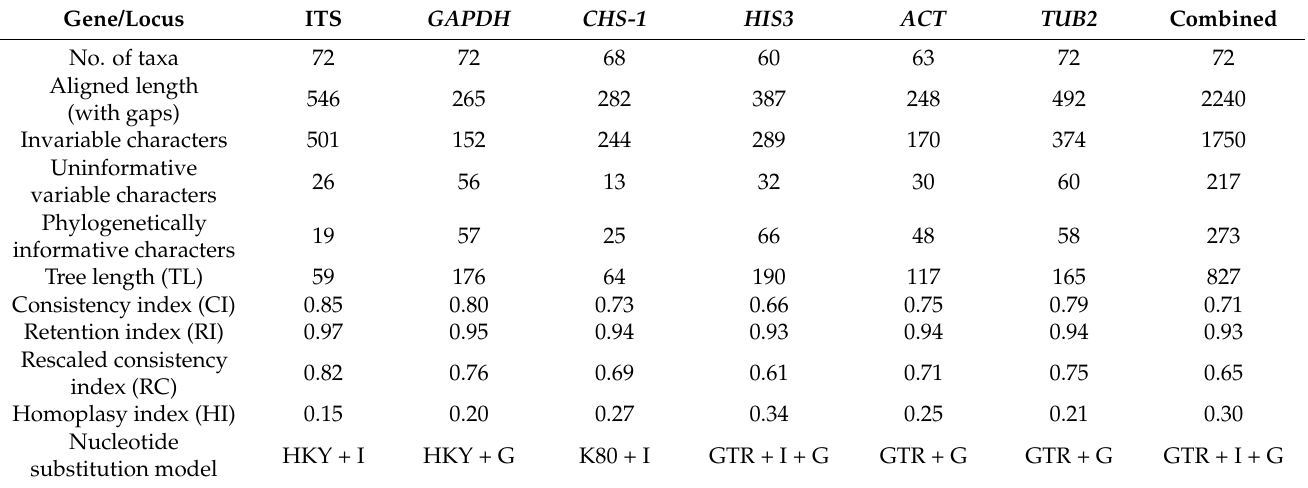
Table 2. Comparison of alignment properties in parsimony analyses of gene/locus and nucleotide substitution models used in phylogenetic analyses of C. acutatum species complex.